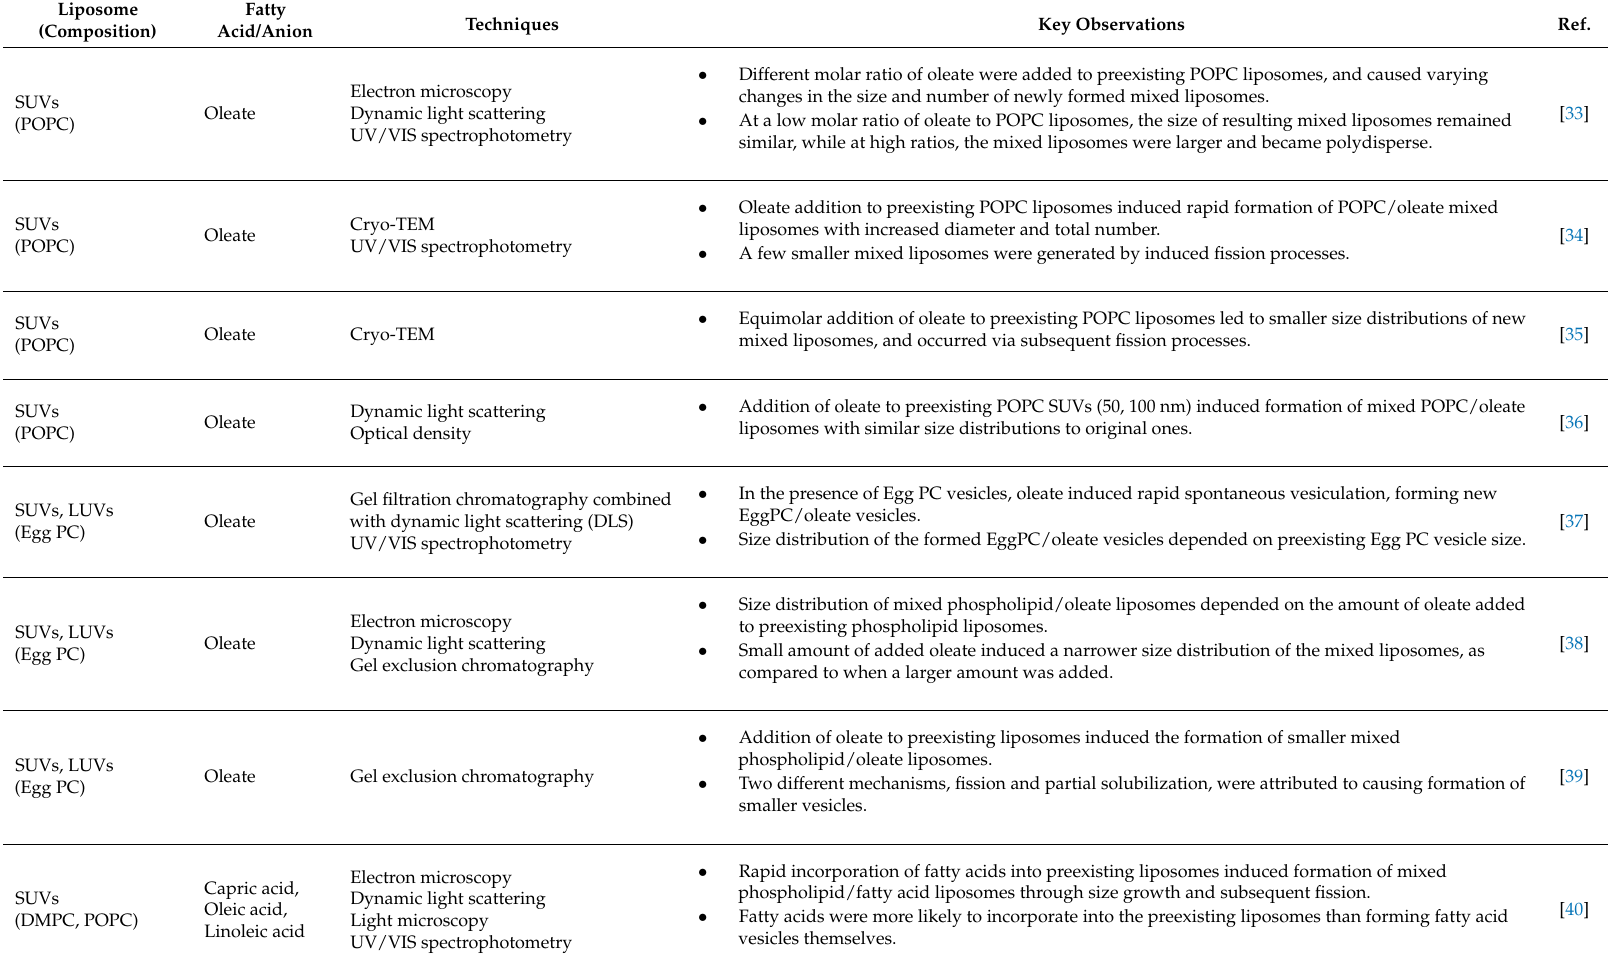
Table 6. Investigation of fatty acid interactions with solution-phase